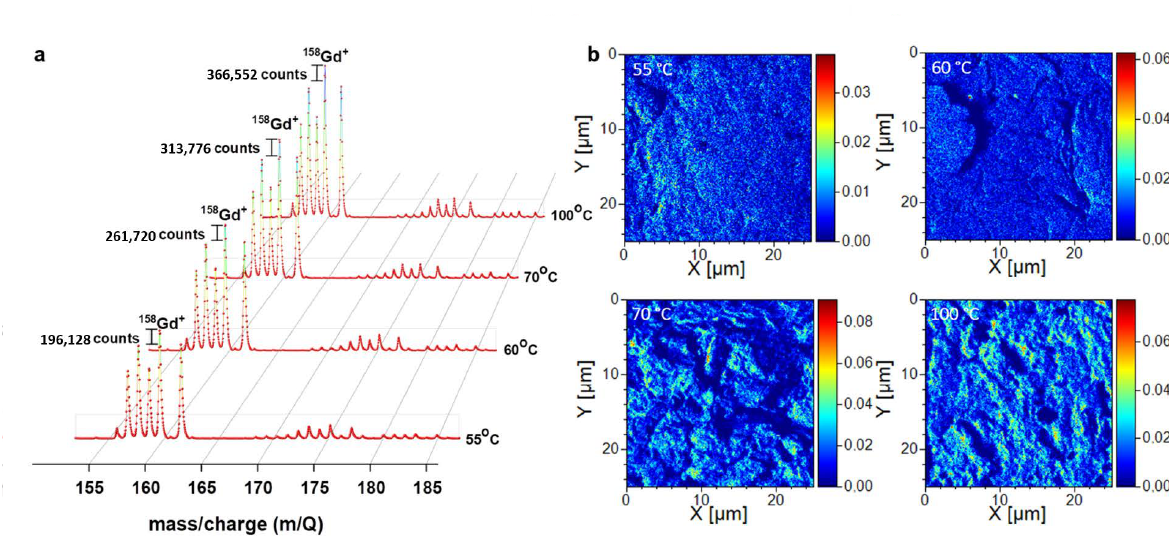
Figure 5. ( a ) ToF-SIMS spectra shows increased Gd counts for samples with a higher degree of functionalization (due to the increased reaction temperature). ( b ) ToF-SIMS element distribution maps reveals the evenly distribution of Gd complex on the carbon nanotube (CNT) surface and further increment of Gd percentage in the CNTs with respect to increased reaction temperature can also be visualized (bright contrast increment).